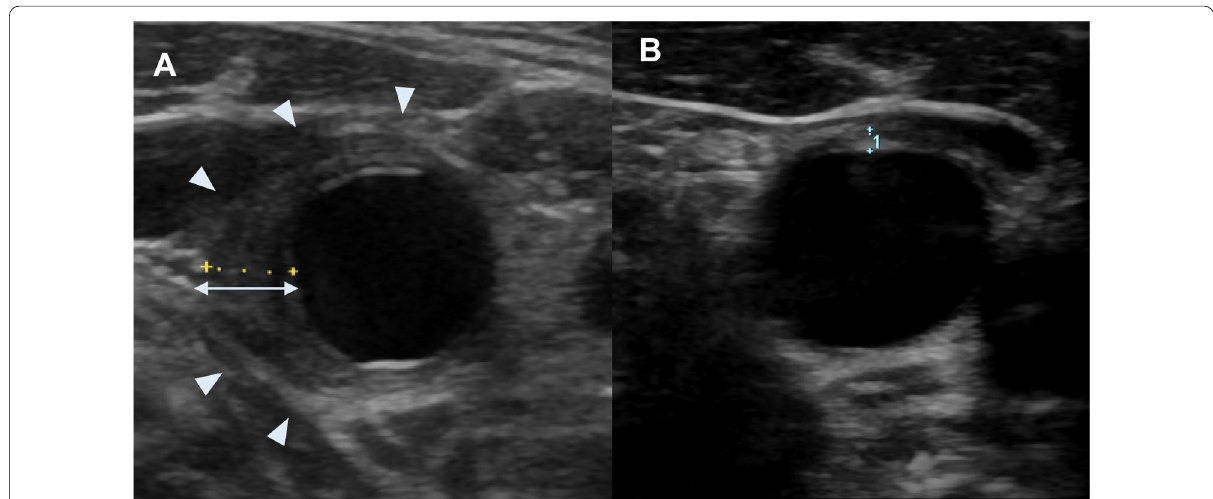
Fig. 3 Carotid artery US images before and after treatment. A US image of the right internal carotid artery on day 8 of hospitalization, revealing hypoechoic or isoechoic wall thickening around the vessels from the bilateral common carotid bifurcation to the bilateral internal carotid arteries (white arrowheads). B US image of the right internal carotid artery on day 22 of hospitalization, showing improvement in the vessel wall thickening after treatment. US ultrasonography